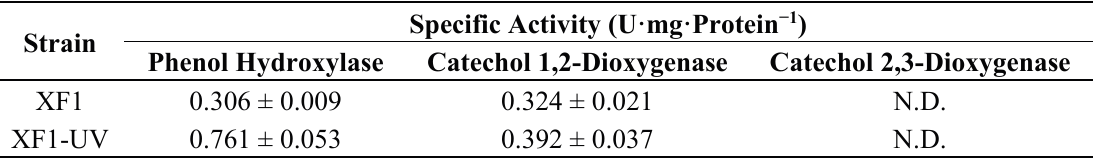
Table 2. Enzymatic activities of phenol hydroxylase, catechol 1,2-dioxygenase, and catechol 2,3-dioxygenase from cell extracts of different isolates of the Pseudochrobactrum sp. XF1 and Pseudochrobactrum sp. XF1-UV